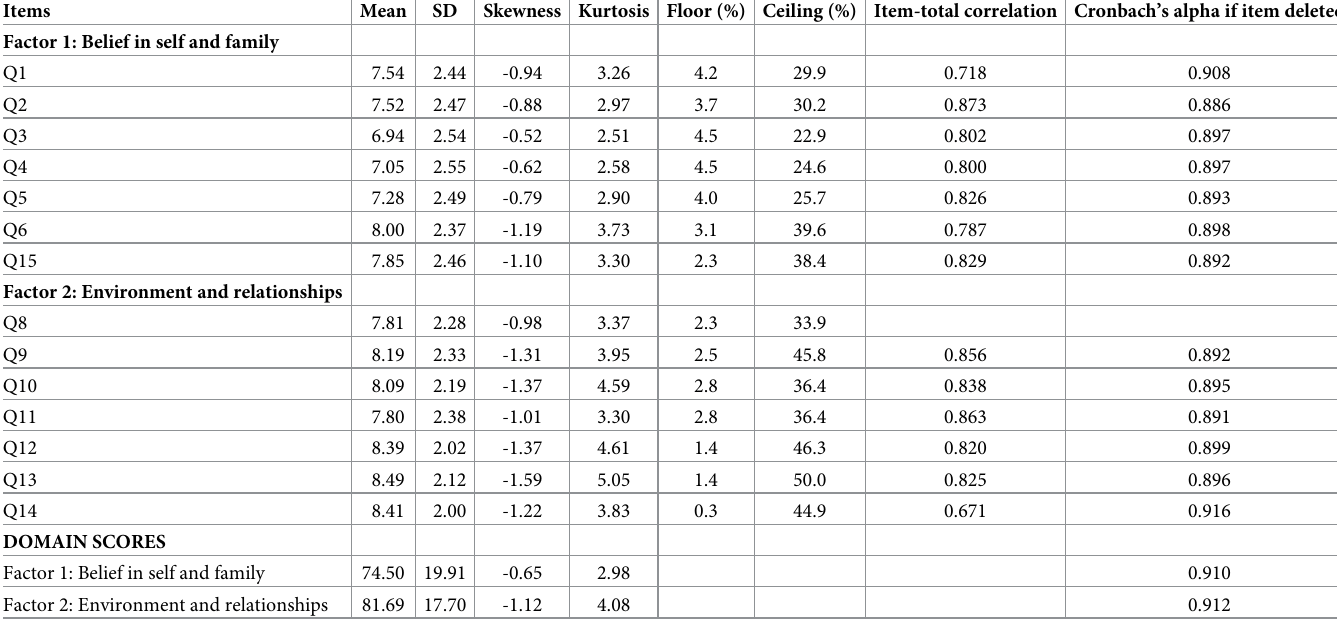
Table 3. Basic descriptions and reliability of YQOL-SF instrument.